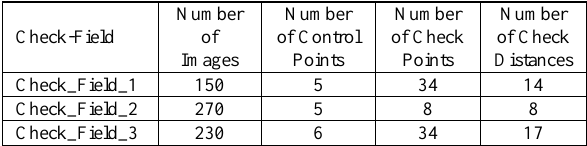
Table 2: Number if images acquired, control and checkpoints, and check distances.